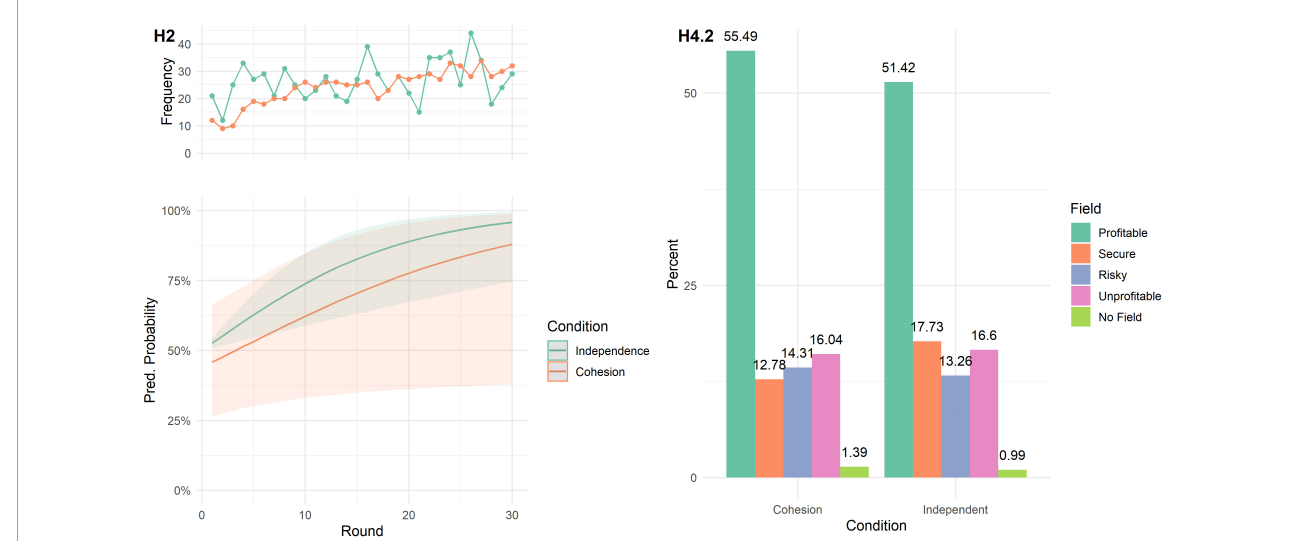
FIGURE5 (H2) Lower panel: Predicted probability of choosing the profitable field in each round. Lines represent the marginal effects, shaded areas represent the 95% C.I. Upper panel: Raw frequency of profitable field choices over rounds, separate for cohesion and independent condition. (H4.2) Relative frequency (percentage) of reward field choices, separate for cohesion and independent condition.